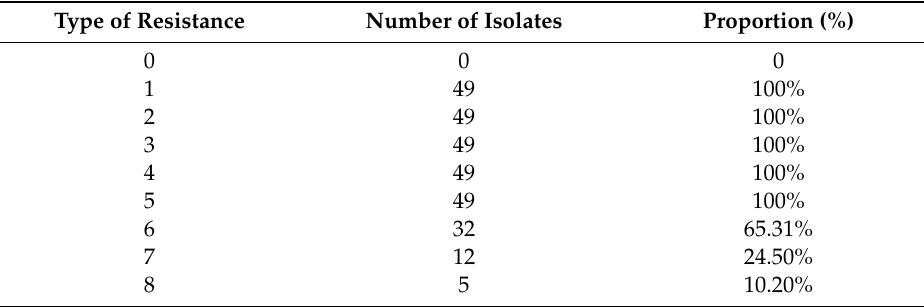
Table 3. Multi-drug resistance of 49 strains of T. halophilus.